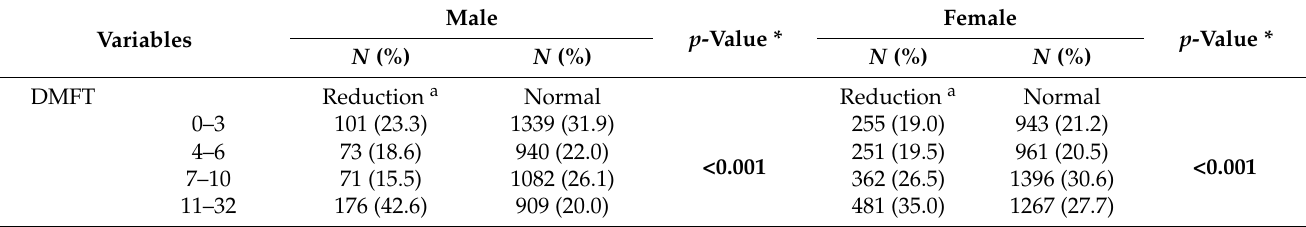
Table 2. Handgrip strength and dental caries according to sex.